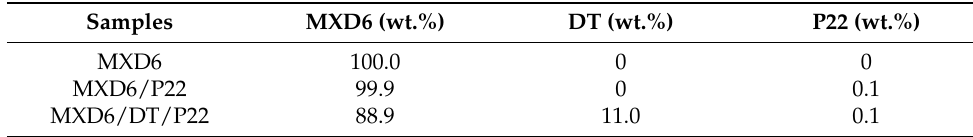
Table 1. The formulation of modified